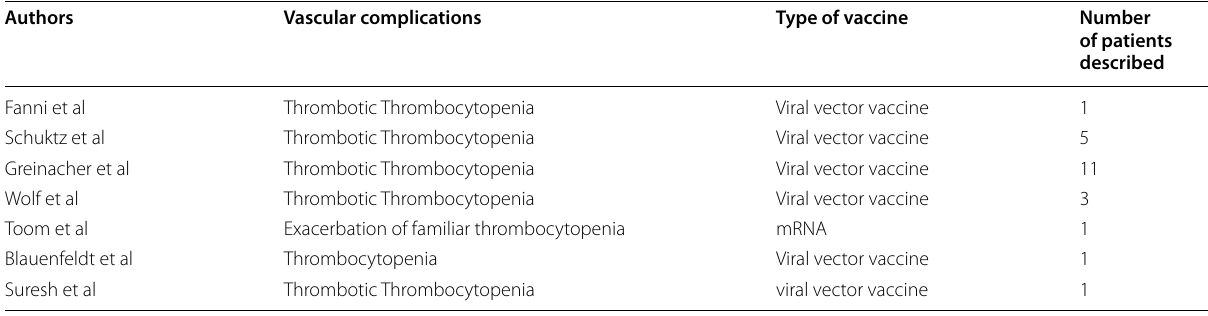
Table 3 Previous case-report about vaccine-related vascular